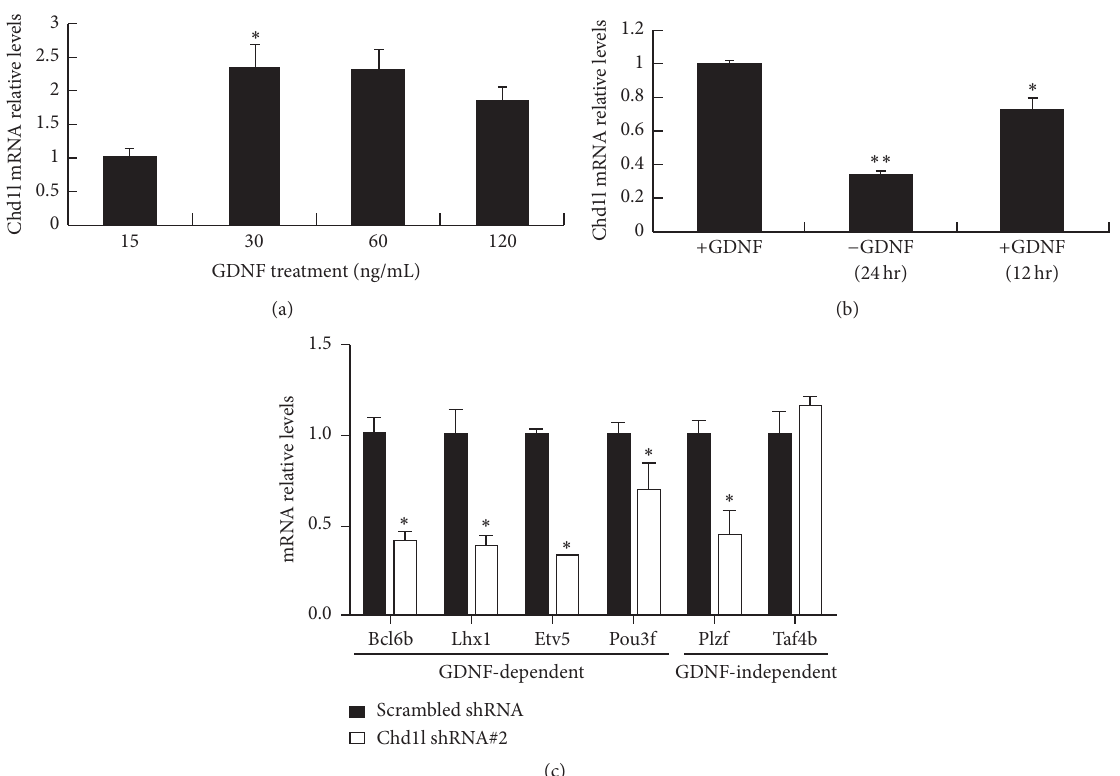
Figure5:Chd1lisinvolvedinGDNFsignalingpathway.(a)EffectsofsupplementationwithhigherlevelsofGDNFon Chd1l geneexpressionin mouseSSCs.(b)EffectsofGDNFwithdrawalorreplacementon Chd1l